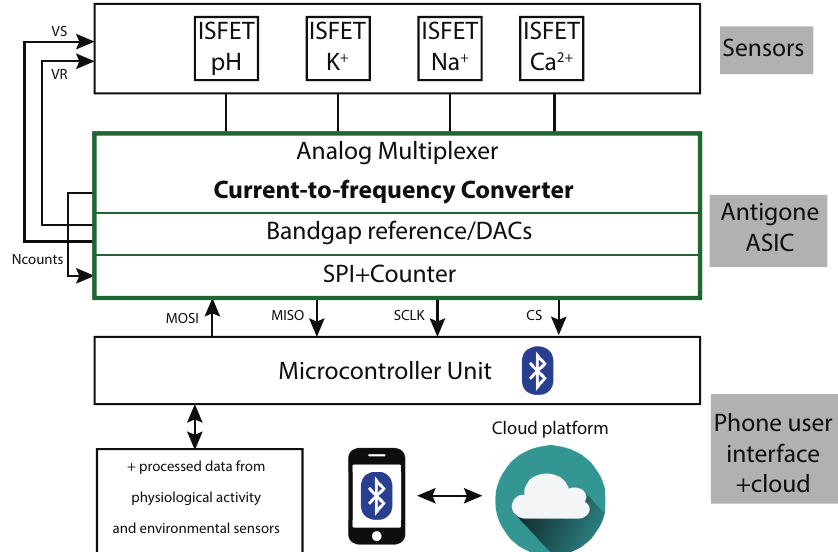
Figure 1. Wearable ISFET-based sweat sensing